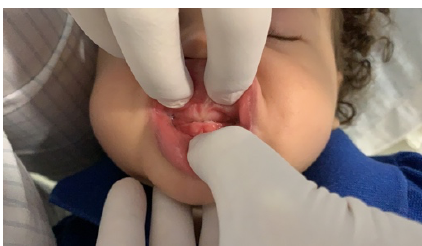
Figure 3. Evaluation of the relationship of the gingival edges during the eruption of the lower primary central incisors.